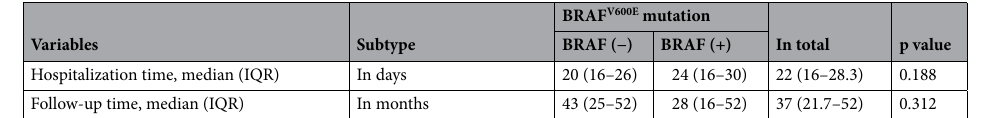
Table 2. Univariate analysis of the relationships between BRAF V600E mutation in GNT and clinicopathology in 102 patients. GG ganglioglioma, DNT dysembryoplastic neuroepithelial tumor, GNT glioneuronal tumor, GTCS generalized tonic–clonic seizure, SE status epilepticus, EEG electroencephalogram, FCD focal cortical dysplasia, HS hippocampus sclerosis, IQR interquartile range. a Patients with unknown results in lateral concordant EEG findings of interictal epileptiform discharges and of ictal seizure rhythms were recorded in 13 cases (no IEDs or normal EEG findings) and 37 cases (no ictus during video EEG monitoring), respectively. b P < 0.05, with significance.